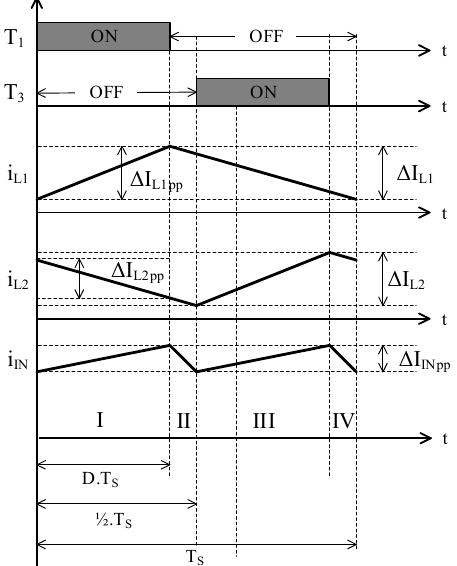
Figure A1. Input and inductor currents for D < ½.